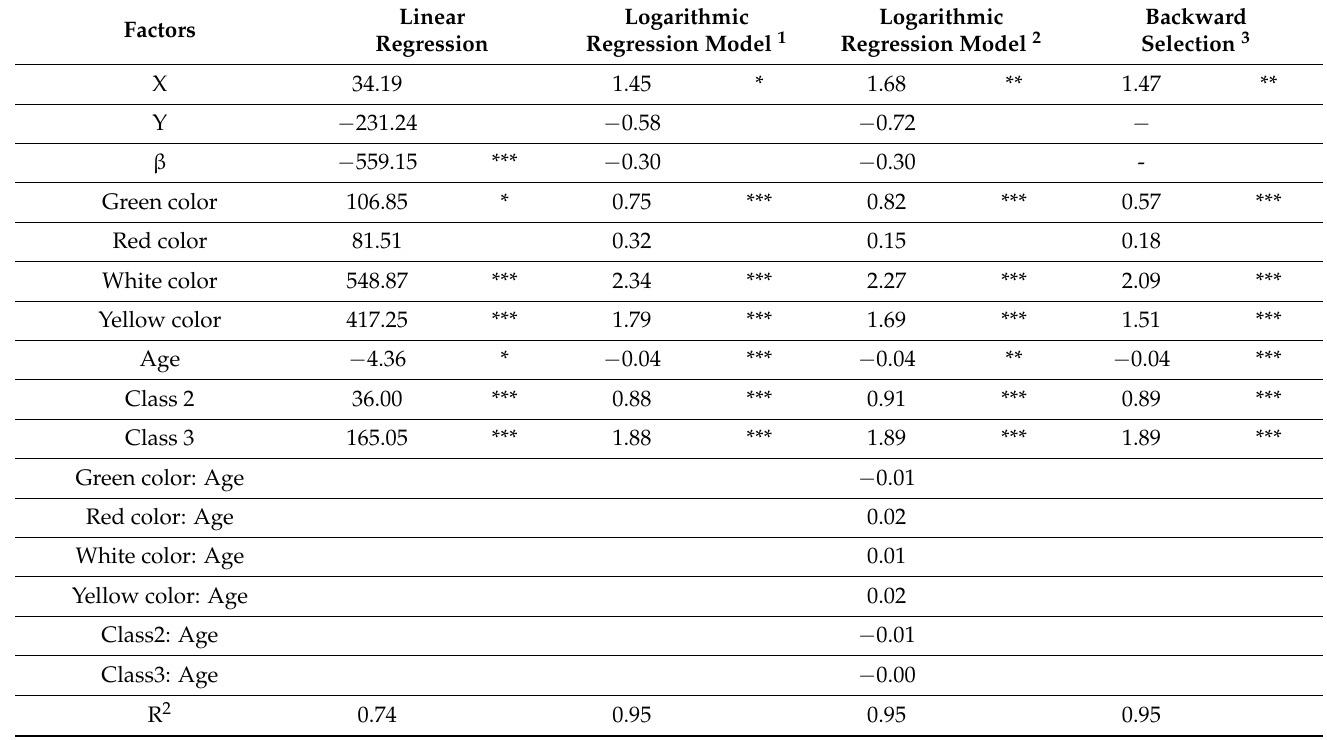
Table 4. The relationship between retroreflectivity and other factors in the NMF